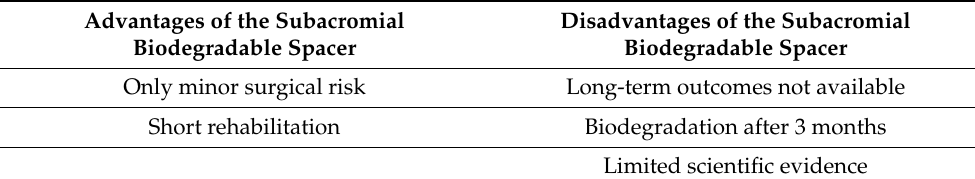
Table 6. Advantages and disadvantages of the subacromial biodegradable